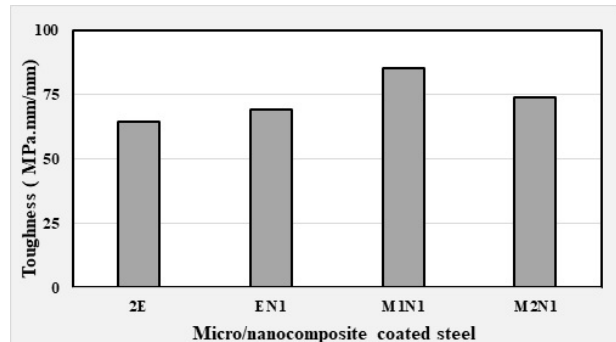
O micro/nanoparticles. 2 3